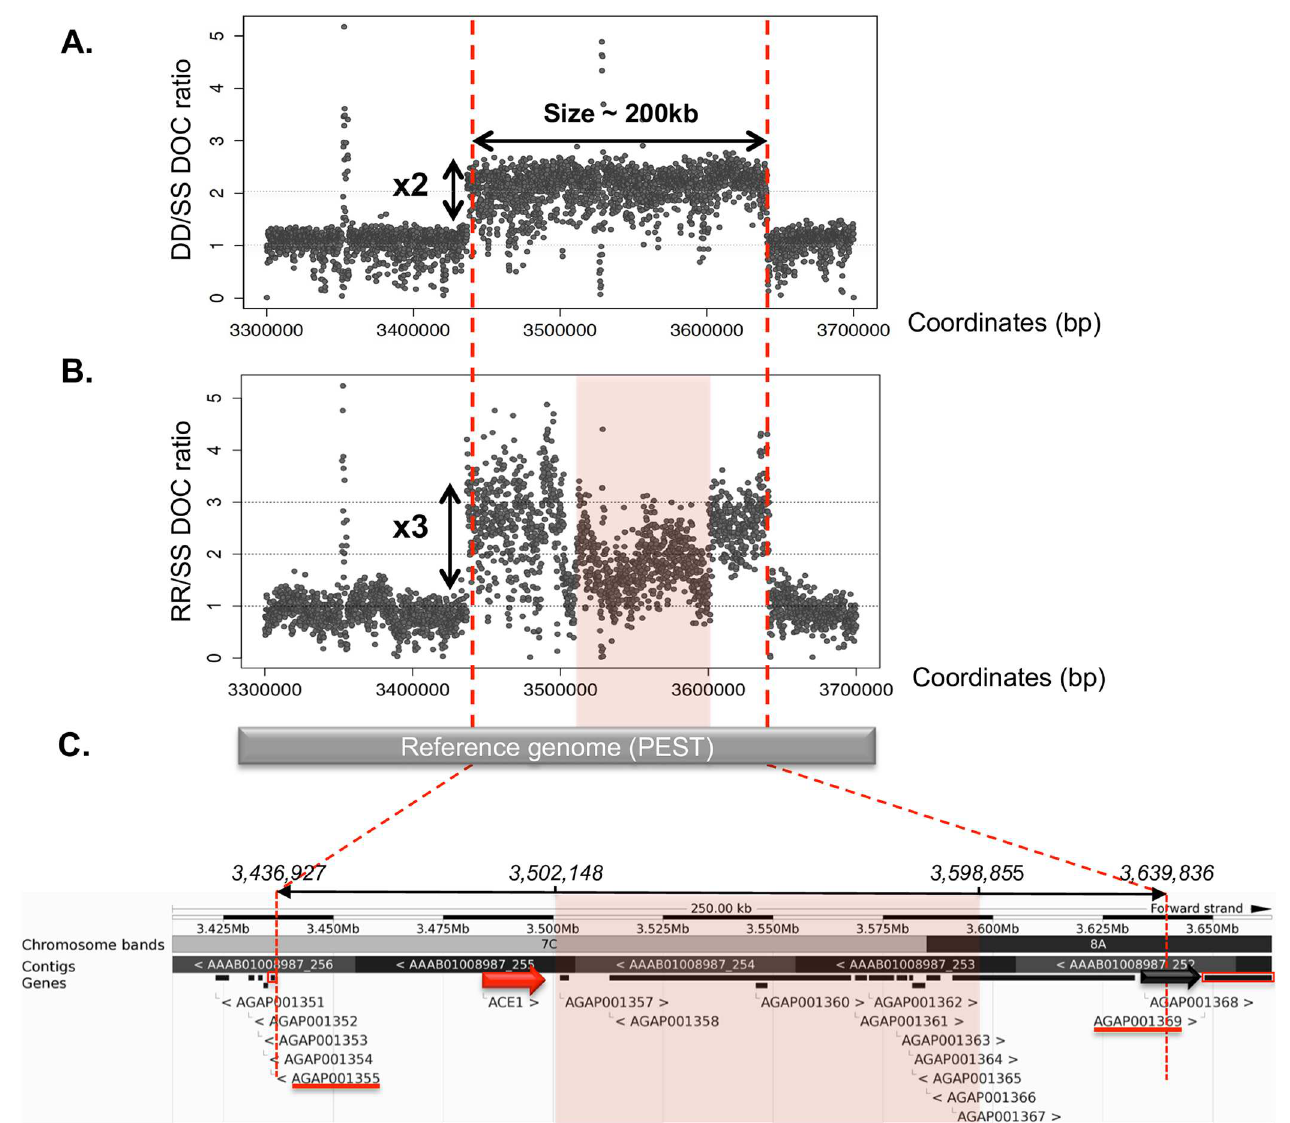
Fig 1. Genomic structure of the 202.91 kb amplicon encompassing the ace-1 gene. (A) Acerduplikisstrain (DD) uniquesegmentalduplication event based on the DD/SS depth of coverage(DOC) ratio (SS corresponds to the KisumuP strain). (B) Acerkis strain (RR) multiple segmental duplication events based on the RR/SS DOC ratio. The pink box correspondsto a decrease in DOC by one third within the amplicon,suggesting that there has been a deletionin only one of the three copies. (C) Gbrowse view of the duplicated regionin VectorBase (https://www.vectorbase. org). The duplicated regioncontains12 genes: the ace-1 locus (large red arrow) lies about 50 kb from its 5 ʹ end, and a gene encoding a transposase overlaps its 3 ʹ end (AGAP001368, large black arrow). Genes used as markers to delineatethe ampliconare shown as red boxes, with their names underlinedin red. Underlying data can be found in NCBI